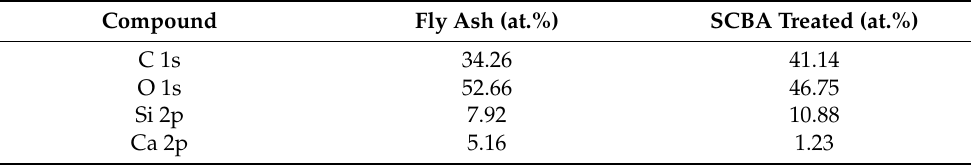
Table 2. Chemical compositions of raw FA and treated SCBA determined by XPS analysis. Compound Fly Ash (at.%) SCBA Treated (at.%)